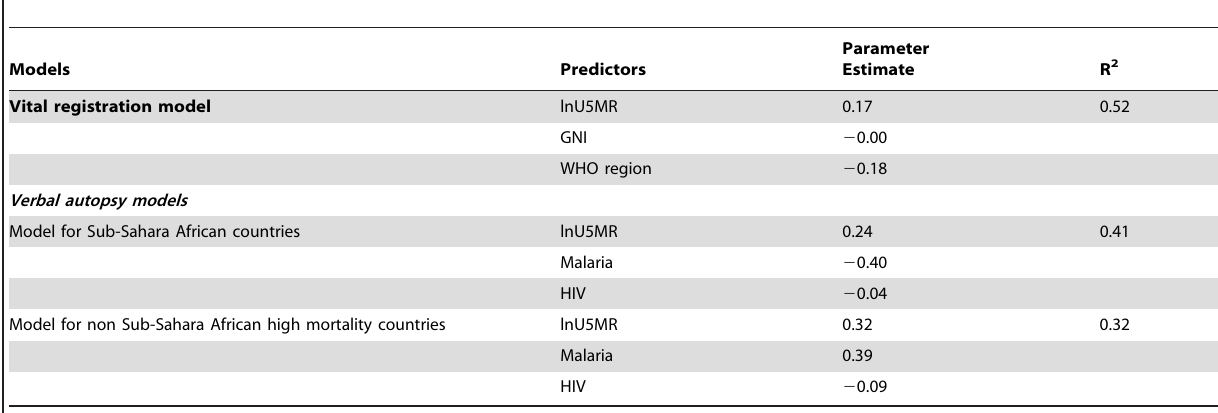
Table 2. Parameter estimates for the vital registration and verbal autopsy models (lnU5MR: Natural logarithm of the under 5 mortality rate; GNI: Gross National Income; WHO: World Health Organisation).